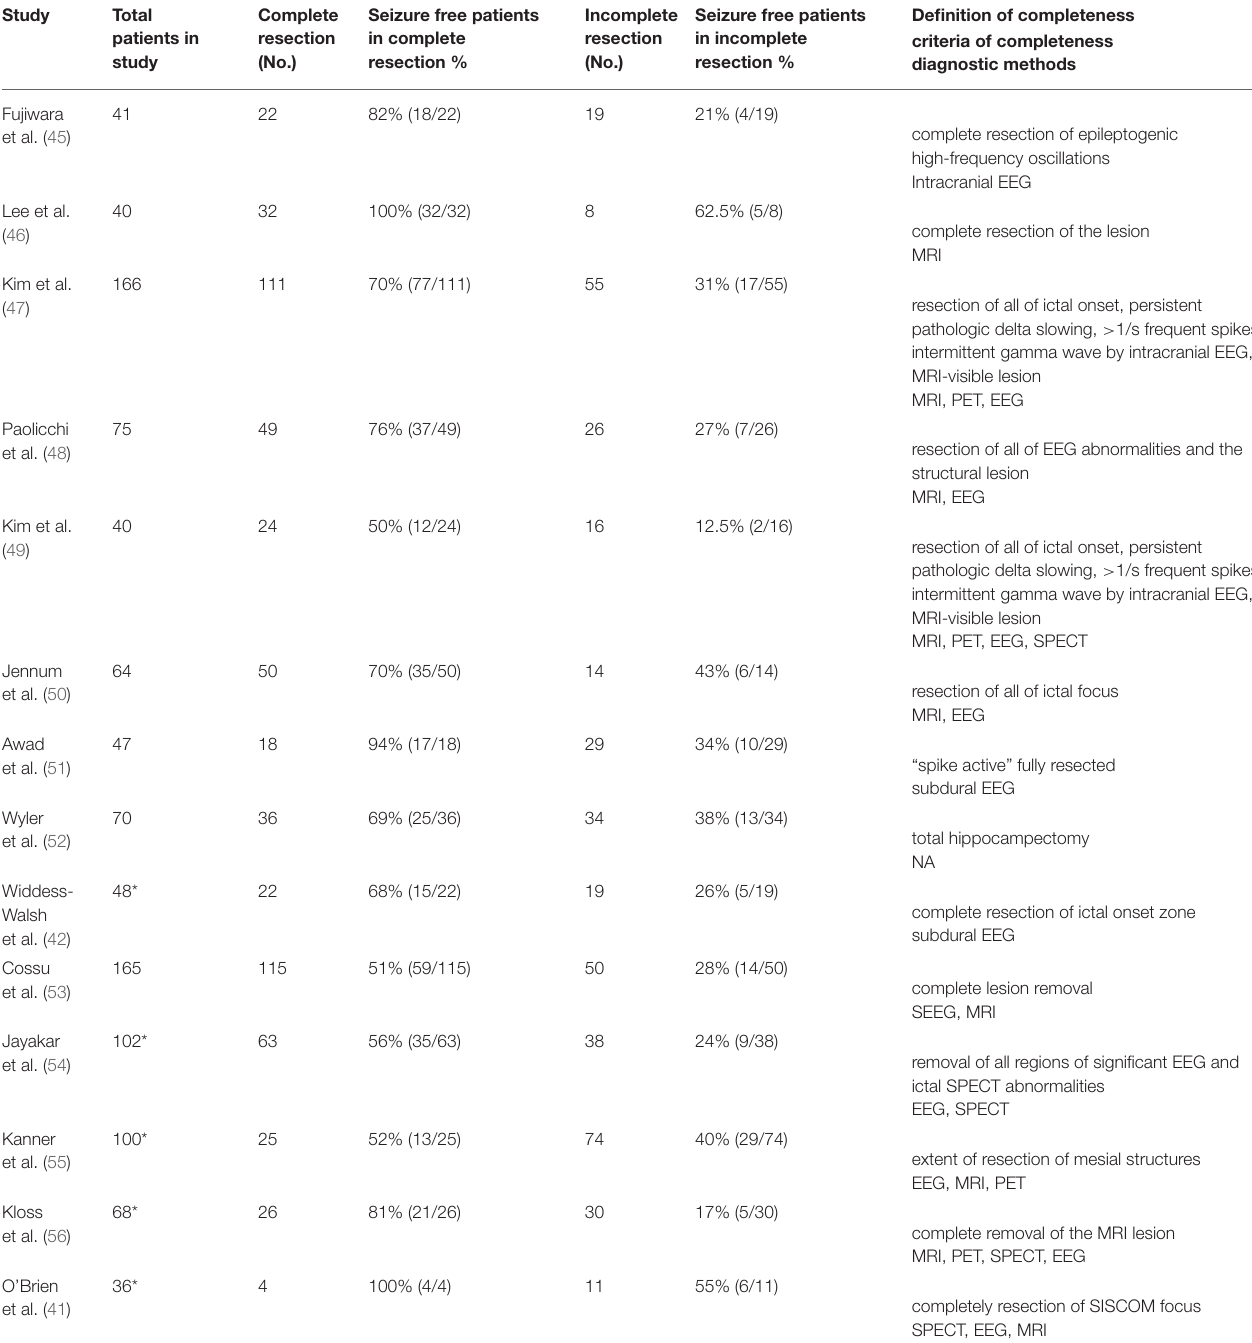
TABLE 2 | Seizure outcome according to the completeness of